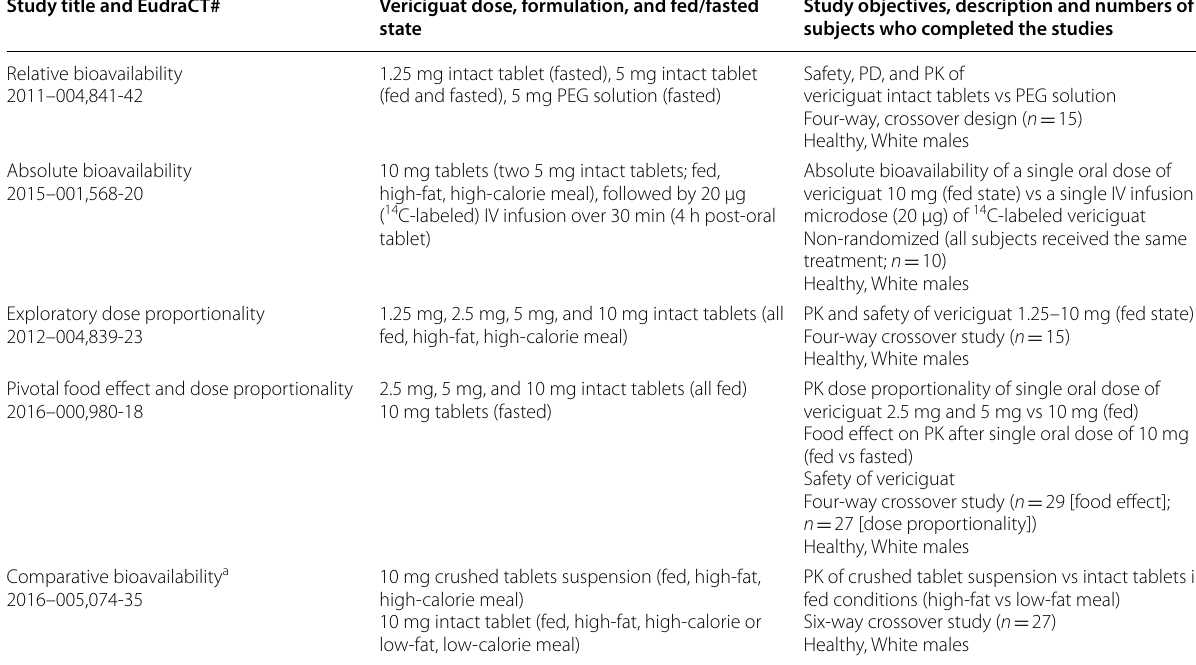
All studies were randomized and included a washout phase of 5 days between treatments, except for the absolute bioavailability study, which was non-randomized ≥ and had no washout. N numbers are the numbers of subjects that completed the studies. For the pivotal food effect study, 29 subjects completed the study (27